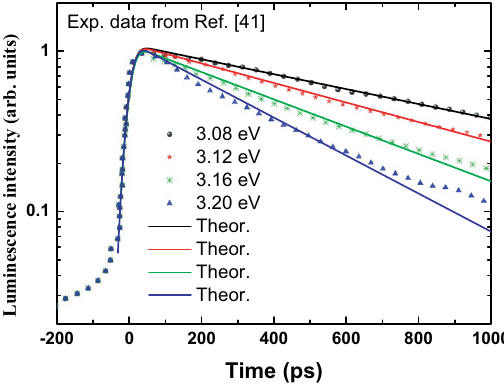
Figure 4. Time-resolved photoluminescence traces (various solid symbols) of a single-layer InGaN alloy measured by Satake et al. for different energy 41 . The solid lines are the fitting curves with Eq. (15).